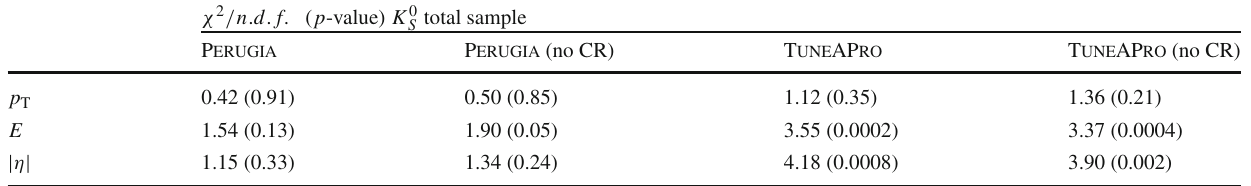
Fig. 12 Kinematic characteristics for the total K 0 out colour reconnection (CR). Total uncertainties are represented by the production, for cor- S shaded area. Statistical uncertainties for MC samples are negligible in rected data and particle-level events from the ACER + Pythia6 gener- comparison with data ator with two different tunes: Perugia and TuneAPro , with and with- Table 11 Values of the χ 2 per degree of freedom and their corresponding p -values, for the total K 0 production, along with the Acermc + Pythia6 S predictions with the following tunes: Perugia and TuneAPro (with and without colour